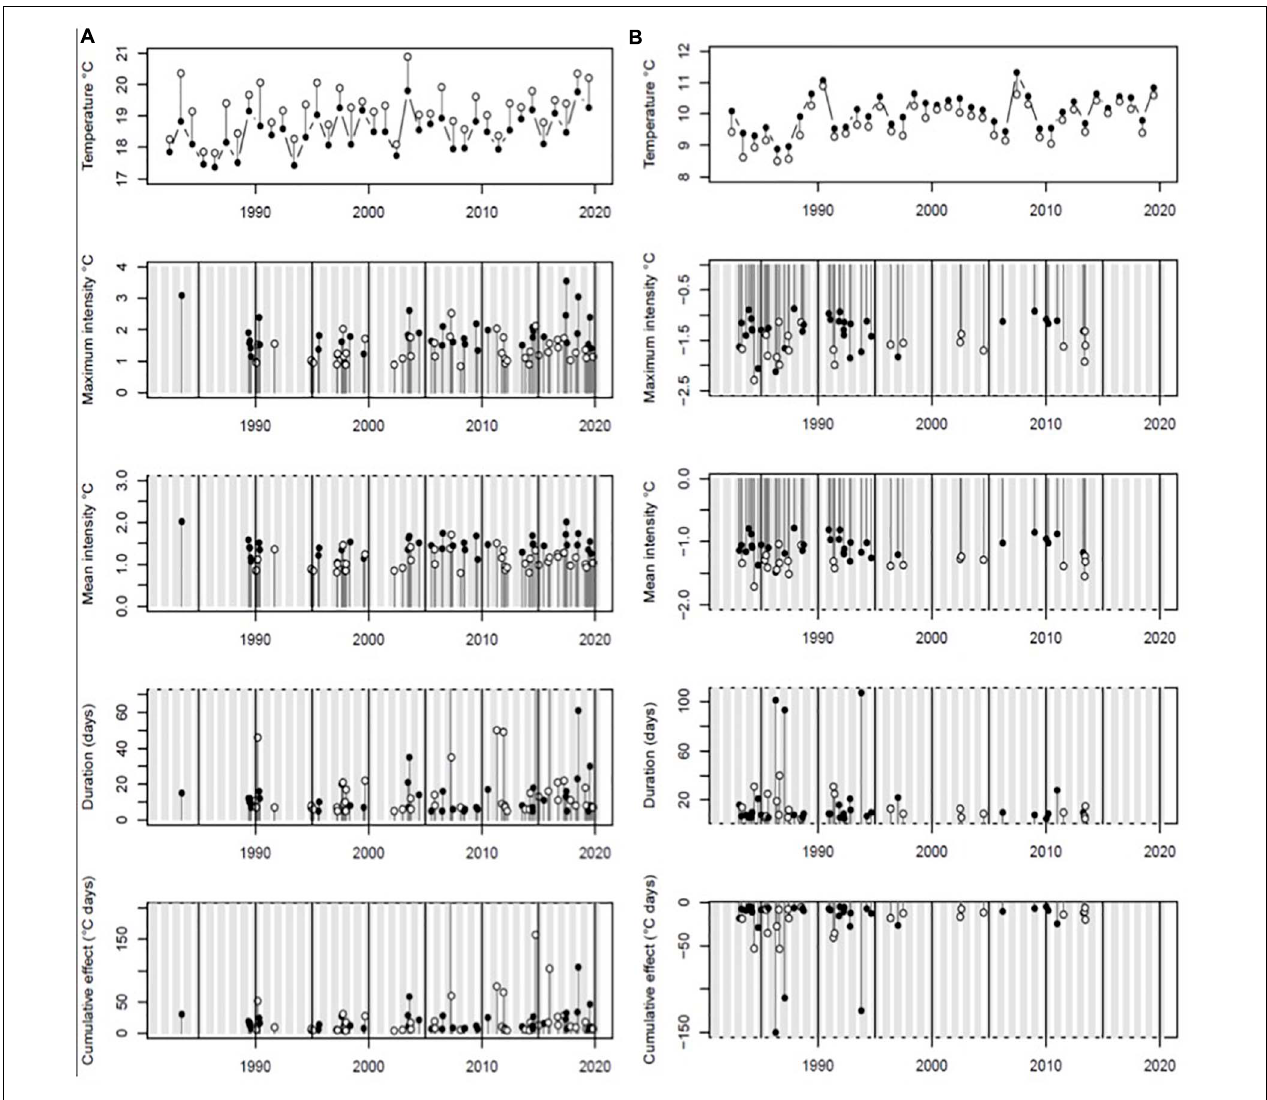
FIGURE 1 | (A) Heatwaves, (B) cold spells from 1982 to 2020. Top plots show (A) 95th percentile (closed circles) and maximum values (open circles) of daily SSTs per year and (B) 5th percentile and minimum daily temperatures per year. Summer heatwaves (May to September) and winter cold spells are shown by filled circles, with winters and summers shown shaded and blank,